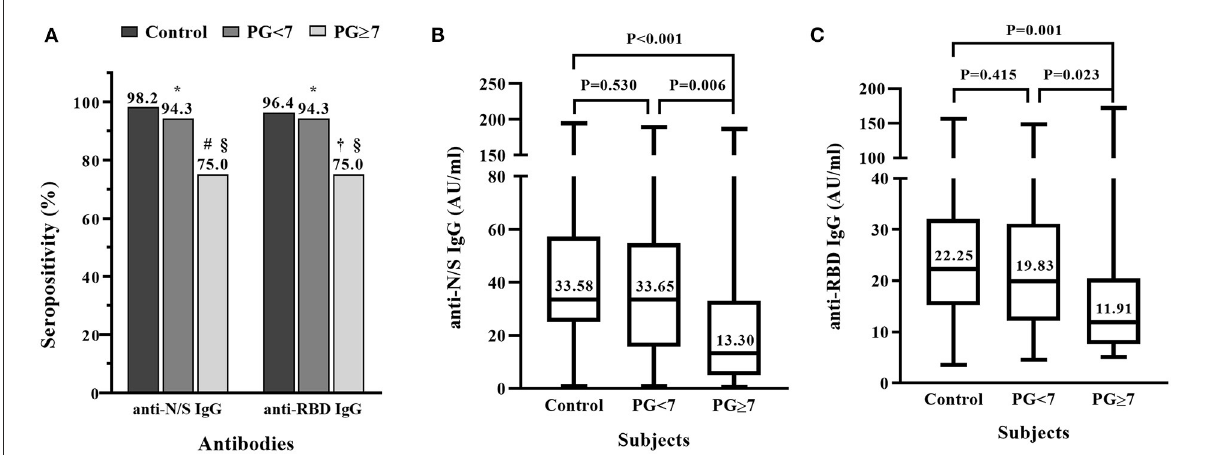
FIGURE2 Comparison of IgG antibody response to inactivated COVID-19 vaccine in patients with diabetic mellitus (DM) who had controlled or uncontrolled fasting blood glucose and non-DM subjects. Thirty-five DM patients who had plasma glucose (PG) < 7 mMol/L, 28 DM patients who had PG ≥ 7 mMol/L, and 56 non-DM subjects were each vaccinated with two doses of inactivated COVID-19 vaccine. (A) Positive rates of IgG antibody against the combination of nucleocapsid (N) and spike (S) proteins (anti-N/S IgG), and against receptor binding domain (RBD) (anti-RBD IgG). * P > 0.05, compared to control; # P = 0.003, compared to control; † P = 0.009, compared to control; § P = 0.030, comparison of diabetic patients with PG < 7 and ≥ 7 mMol/L. (B) Comparison of titers of anti-N/S IgG between controls and diabetic patients with PG < 7 and ≥ 7 mMol/L, respectively. (C) Comparison of titers of anti-RBD IgG between controls and diabetic patients with PG < 7 and ≥ 7 mMol/L,